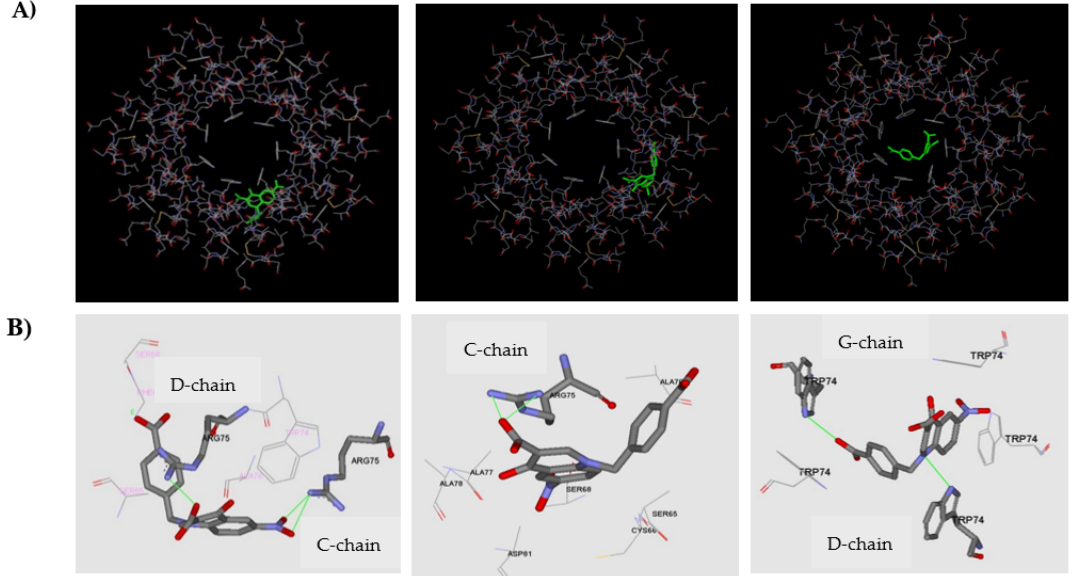
Figure 9. Docking of compound 6g . Three lower-energy poses of 6g in the extracellular domain of the PANX1 channel (panel A ). Particular of the hydrogen bond interactions between 6g and the Arg75 and Trp74 (panel B ).